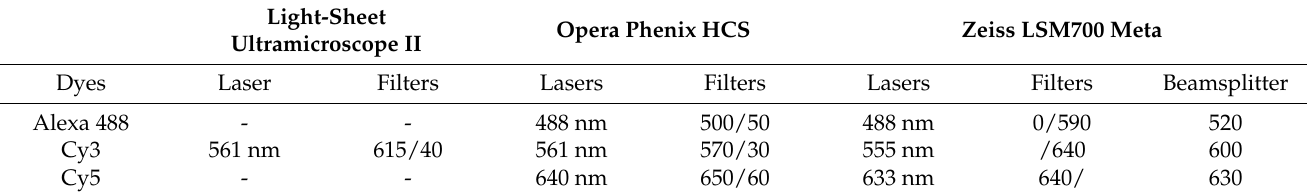
Table 3. Laser and filters per microscope per